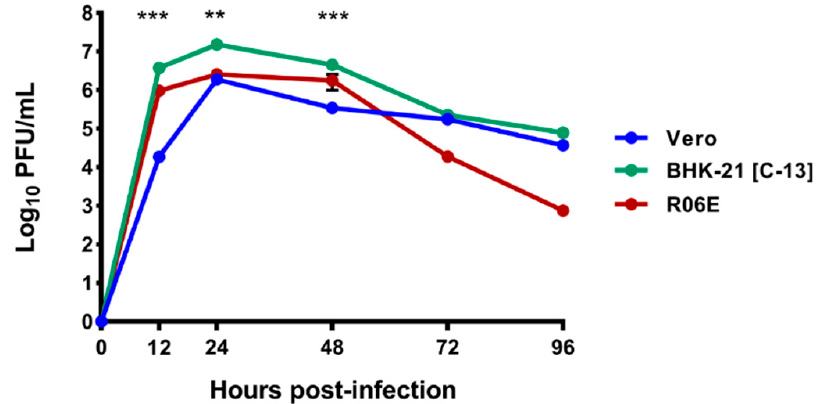
Figure 6. Comparison of growth kinetics of BUKV in Vero, BHK-21 [C-13], and R06E cells when infected at MOI 0.01. Means and SEs from three independent replicates are shown. Statistics were performed using a two-way ANOVA with Tukey’s correction at each time point. p -values: 12 hpi: <0.0001 (Vero vs. BHK-21 [C-13]), 0.0328 (Vero vs. R06E), <0.0001 (BHK-21 [C-13] vs. R06E; 24 hpi: